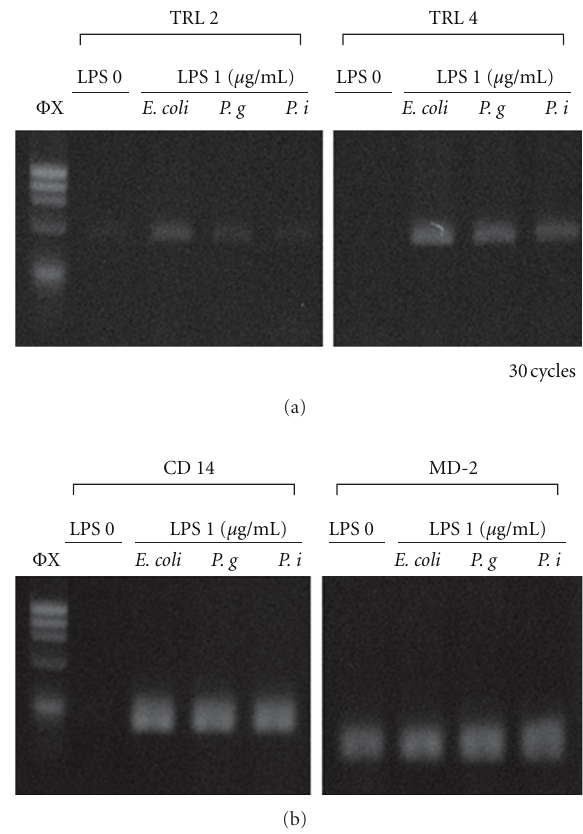
Figure 2: Expression of LPS receptors and their signaling factor’s genes with several LPS stimulation in human fibroblasts. TRL 2, TRL 4, CD14, and MD-2 gene expression in hGF cultures with di ff erent types of LPS stimulation: E. coli , P. gingivalis , P. intermedia, and without LPS for 2 hours. 1 μ g/mL of LPS was used in the experiment. mRNA was isolated at 2 hours. RT-PCR was carried out at di ff erent annealing temperature that TRL2 and CD14 were 57 degrees, and TRL 4 and MD-2 were 54 degrees. PCR cycle was 30 cycles for all genes.